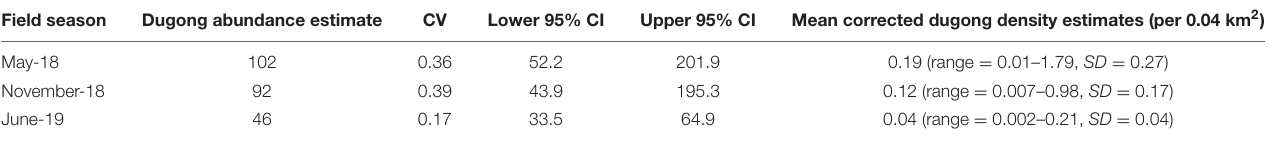
TABLE 3 | Dugong abundance and density estimates based on corrected dugong counts (uncorrected dugong density estimates are provided in Supplementary Material 4